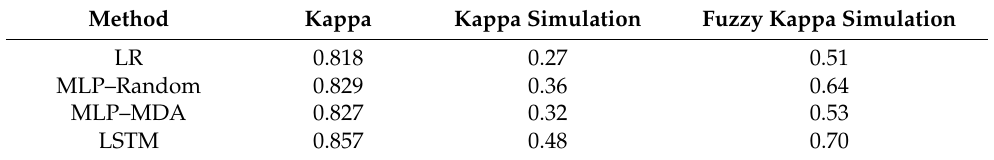
Figure 5. Simulation results of year 2014, Liangjiang New District. Table 3. Validation results of (fuzzy) kappa simulation of four types of models.